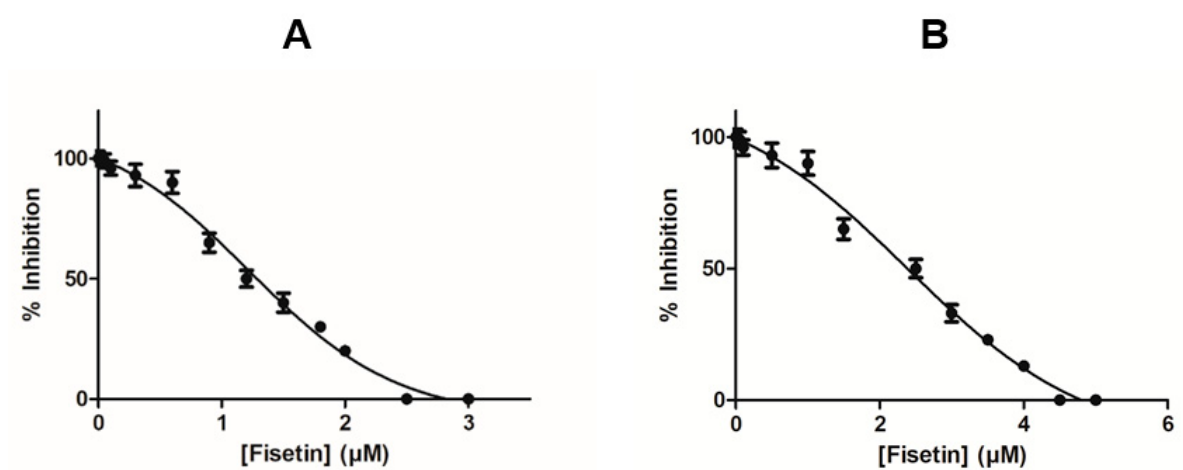
Figure 2. Concentration–response curves for the determination of IC 50 values for fisetin. The graph was produced using GraphPad Prism 5. ( A ) Concentration–response curve using recombinant hGSTA1-1. ( B ) Concentration–response curve using CaCo-2 cell-free crude extract.